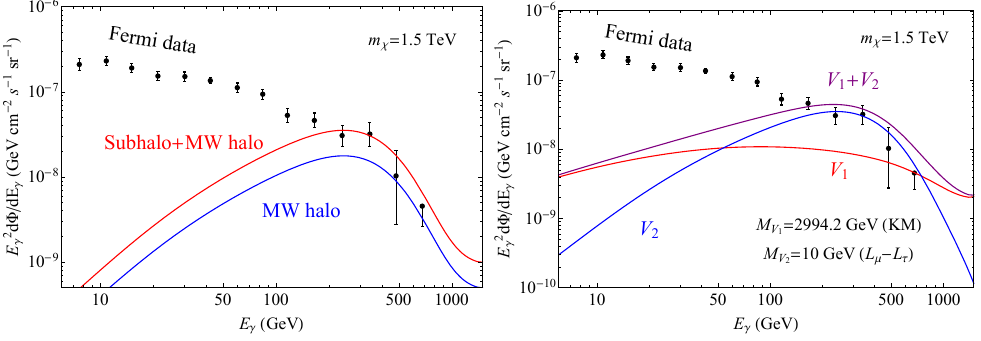
Figure 8 . Left panel: Fermi IGRB data [61] and gamma rays from DM where V 1 is electrophilic and V 2 is L (cid:22) (cid:0) L (cid:28) gauged. Right panel: Fermi IGRB data and gamma rays from DM where V 1 is kinetically mixed with SM hypercharge and V 2 is L (cid:22) (cid:0) L (cid:28) gauged and has a mass of 10 GeV. DM annihilation cross sections are the same as those in (cid:12)gure 4. We use the default subhalo parameters for both